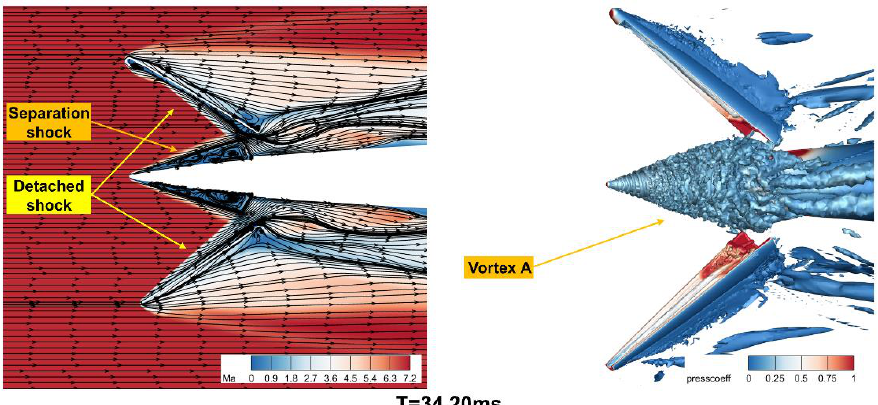
Figure 29. The contour of the streamline and Mach number ( left ), and iso-surface of Q-criterion ( right ) at Time = 34.20 ms.